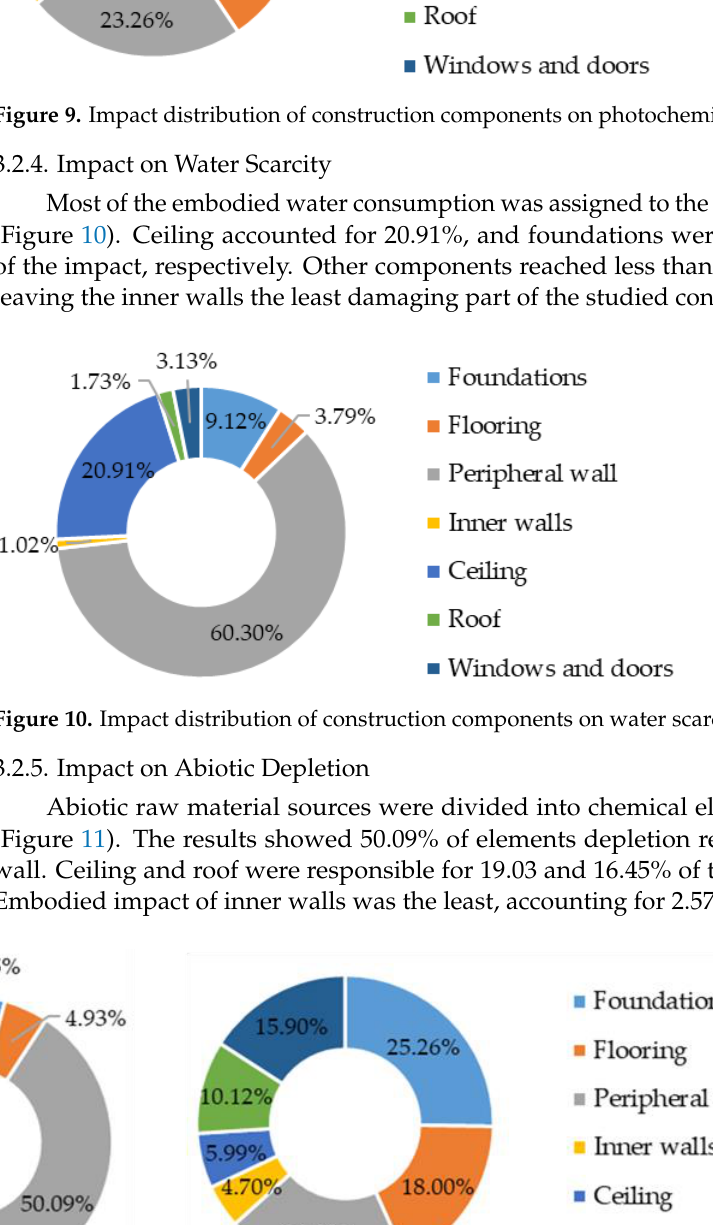
Figure 9. Impact distribution of construction components on photochemical oxidation.